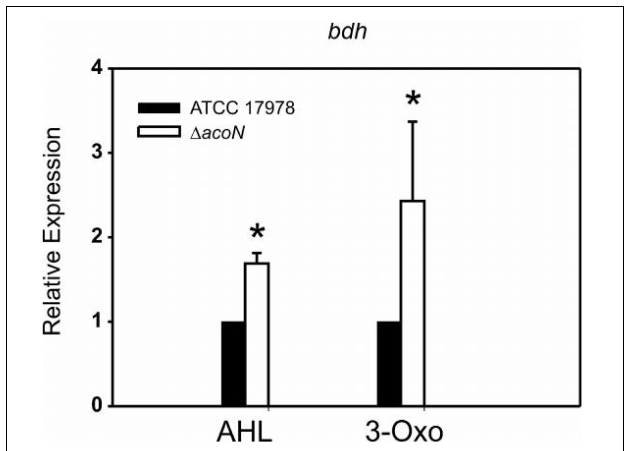
FIGURE 3 | The BDH ( bdh ) gene is induced by quorum network signals in the (cid:49) acoN mutant. Estimation of the relative levels of the BDH mRNA by qRT-PCR in the presence of AHLs or 3-oxo-C12-HSL in the wild-type A. baumannii ATCC 17978 and (cid:49) acoN genetic backgrounds. The data shown are mean ± SD of the expression levels relative to the wild type from at least three biological replicates. Asterisks indicate significant differences in (cid:49) acoN compared to wild type as indicated by t -test ( p < 0.01).